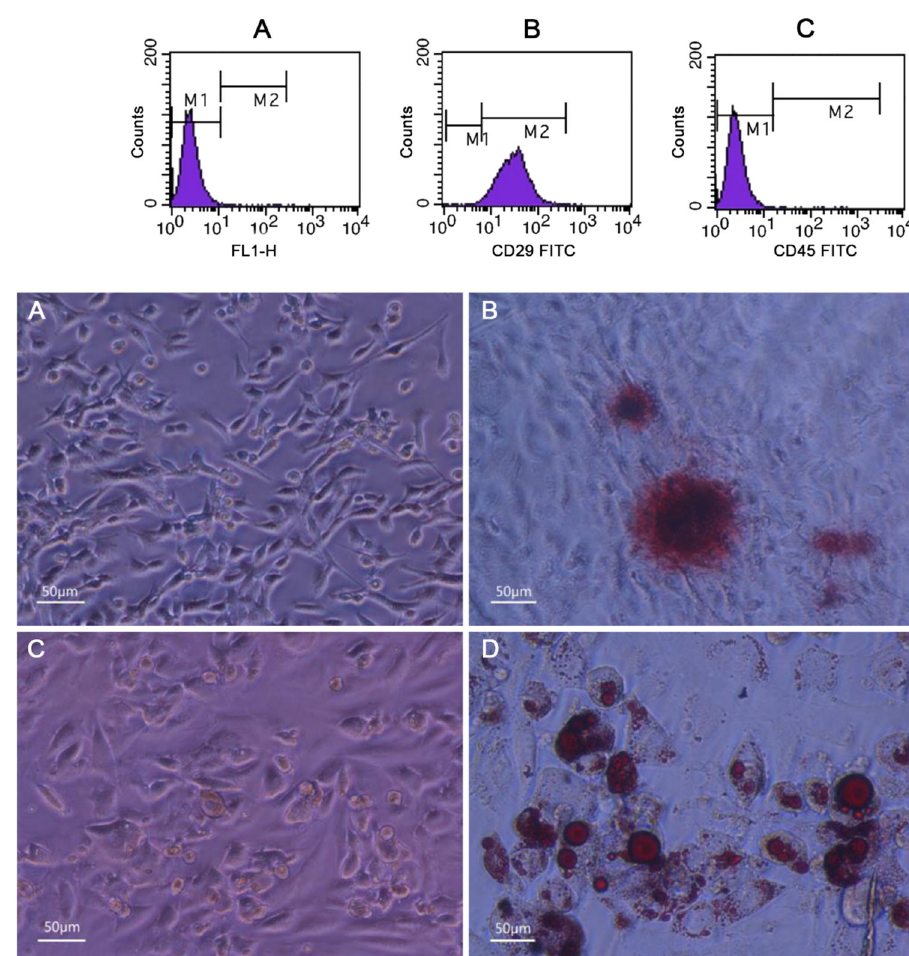
Fig. 1 Expression of CD29 and CD45 on the surface of ADMSCs. a Control group; b CD29-FITC; c